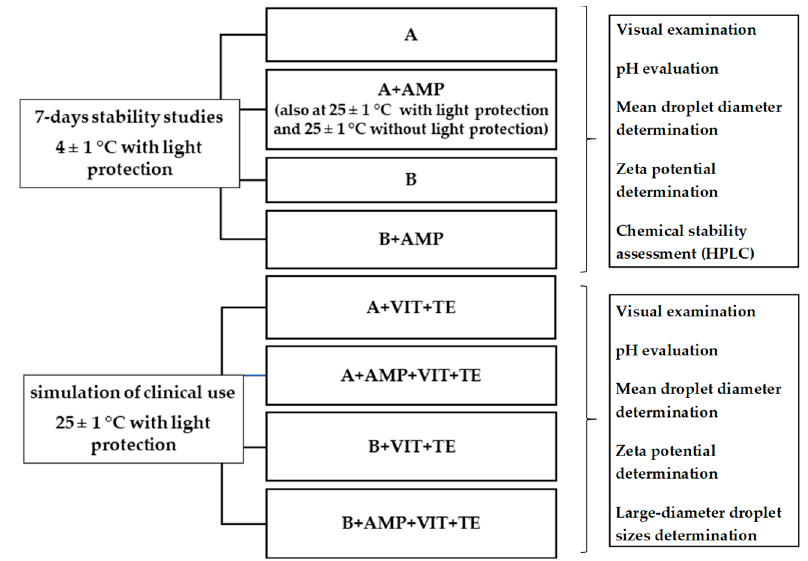
Figure 1. Diagram of study design. TPN: total parenteral nutrition; A: Lipofundin ® MCT/LCT-containing TPN admixture without ampicillin; B: LIPIDem ® -containing TPN admixture without ampicillin; A + AMP, B + AMP: TPN admixtures with ampicillin; A + VIT + TE, B + VIT + TE: TPN admixtures with vitamins and trace elements; A + AMP + VIT + TE, B + AMP + VIT + TE: TPN admixtures with ampicillin, vitamins, and trace